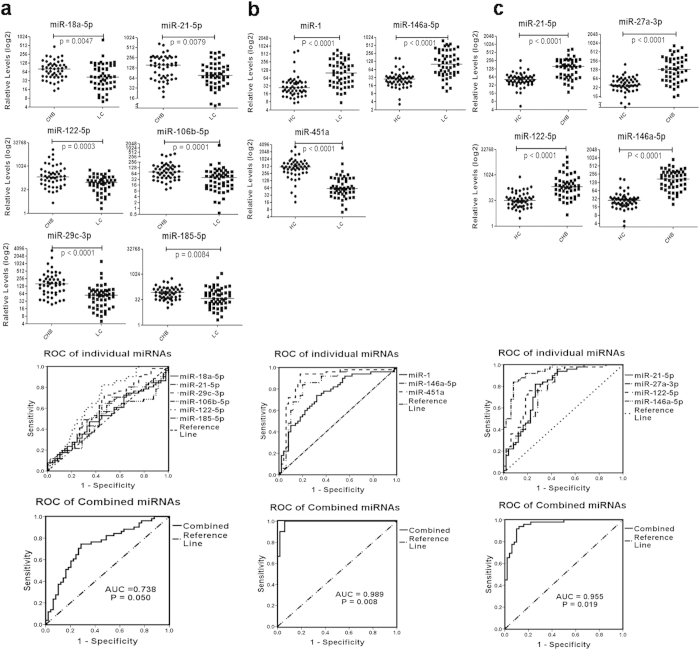
Expression of plasma miRNAs among study cohorts in training phase.Relative expression levels of the miRNAs in plasma and ROC analysis with individual miRNAs and combined miRNA panel between LC and CHB patients (a), LC patients and HC (b), and CHB patients and HC (c) in training phase. P values were calculated using the Mann-Whitney test and p were all <0.01. Logistic regression indicates a linear combination of miRNAs.